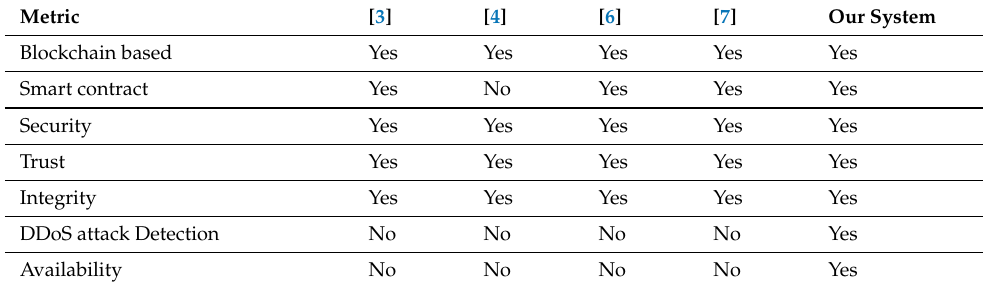
Table 6. Comparison between our proposed system and other related work in smart transport